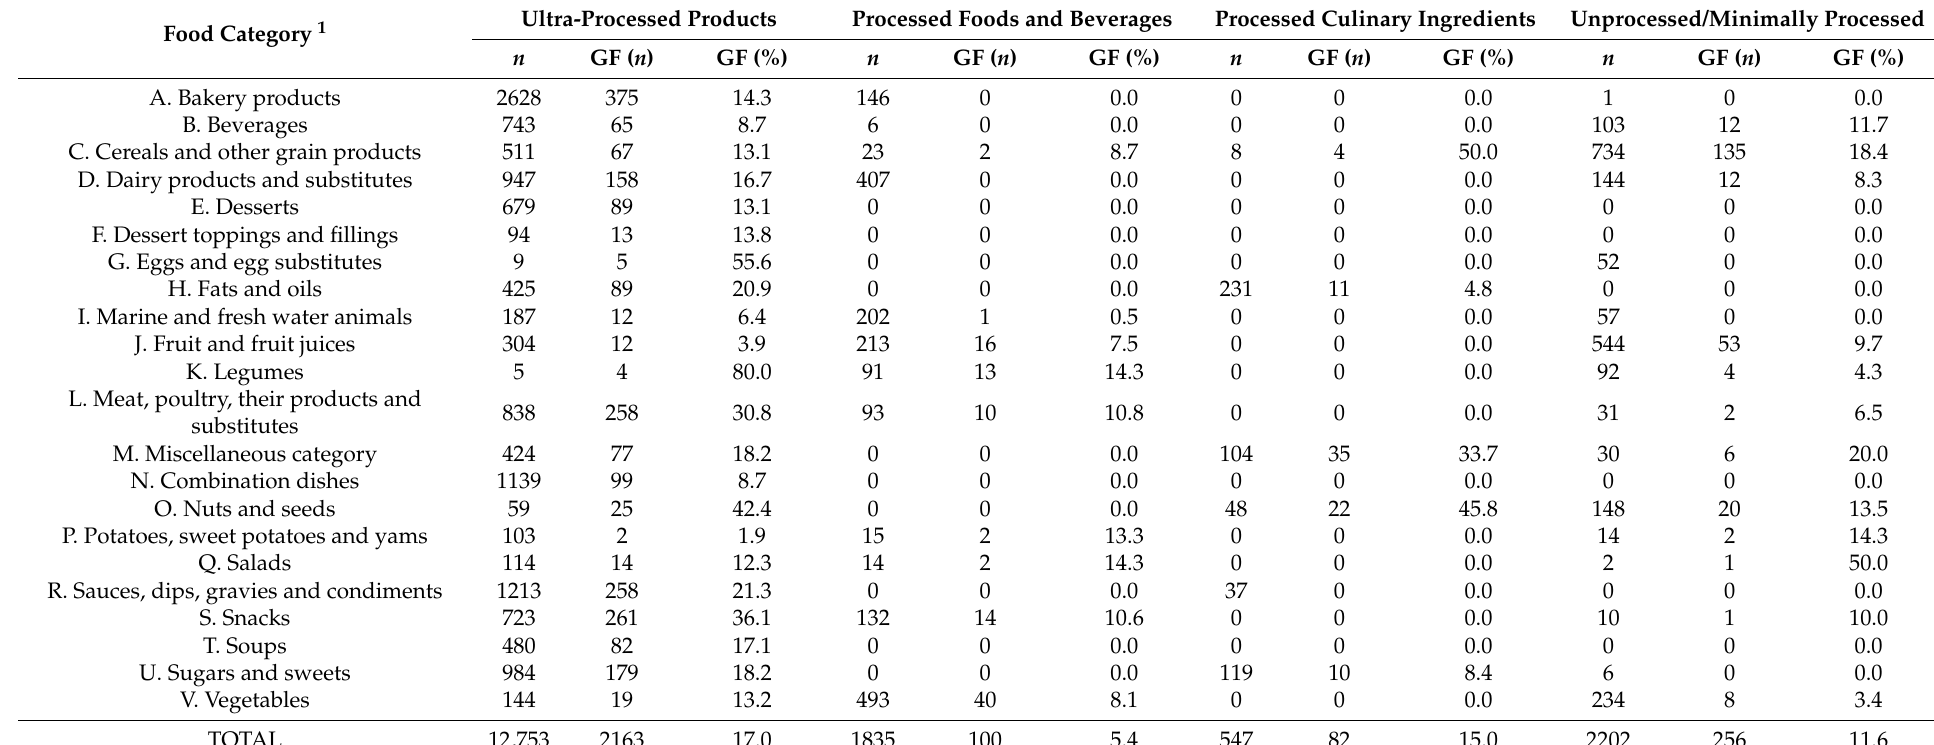
Table 2. The prevalence of products with gluten-free (GF) claims in 2017 by NOVA processing